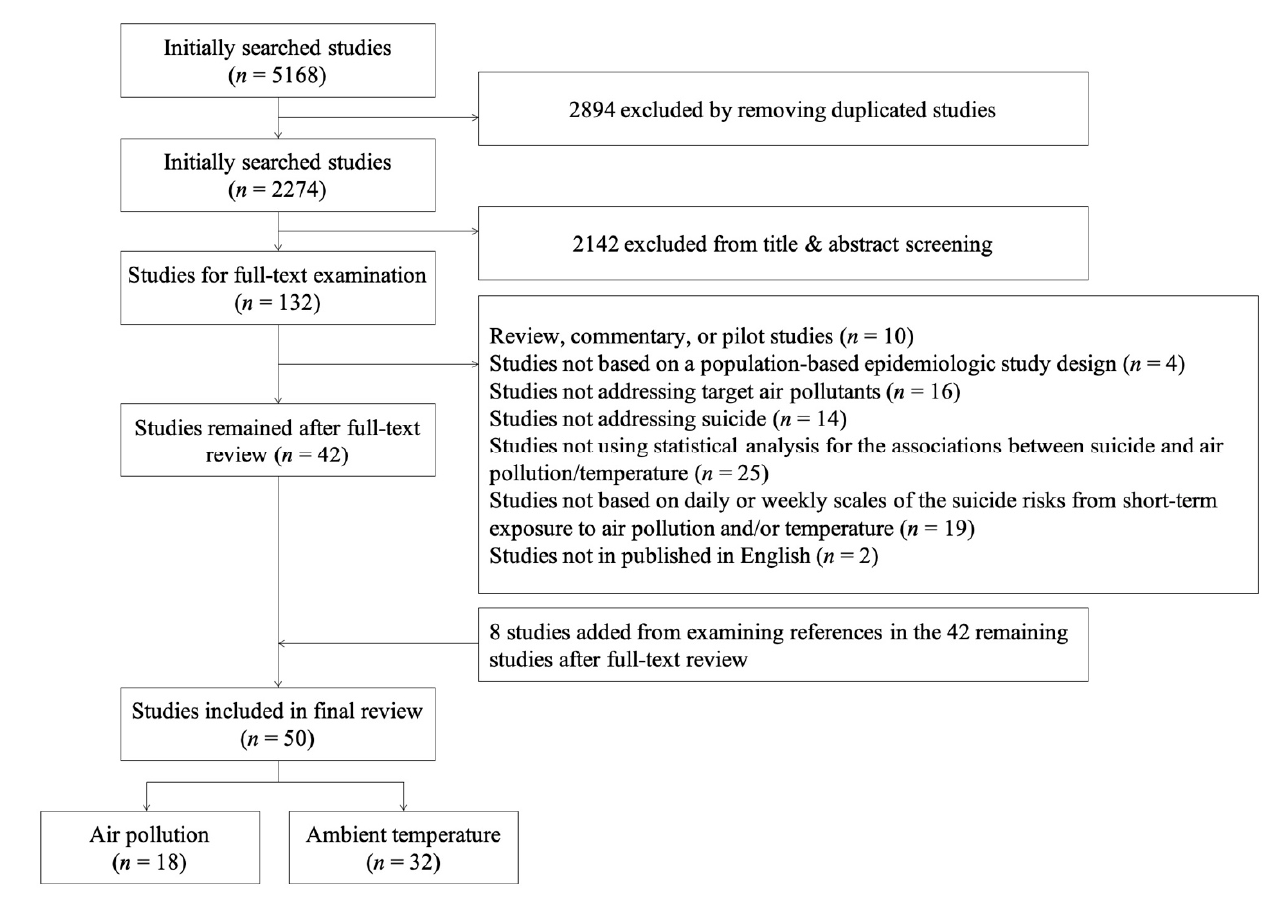
Figure 2. Flowchart of identified studies for systematic review.